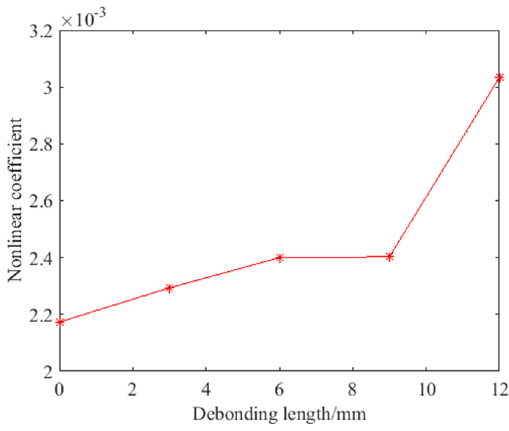
Figure 12. The variation curves of the nonlinear coefficient using nonlinear harmonics method.